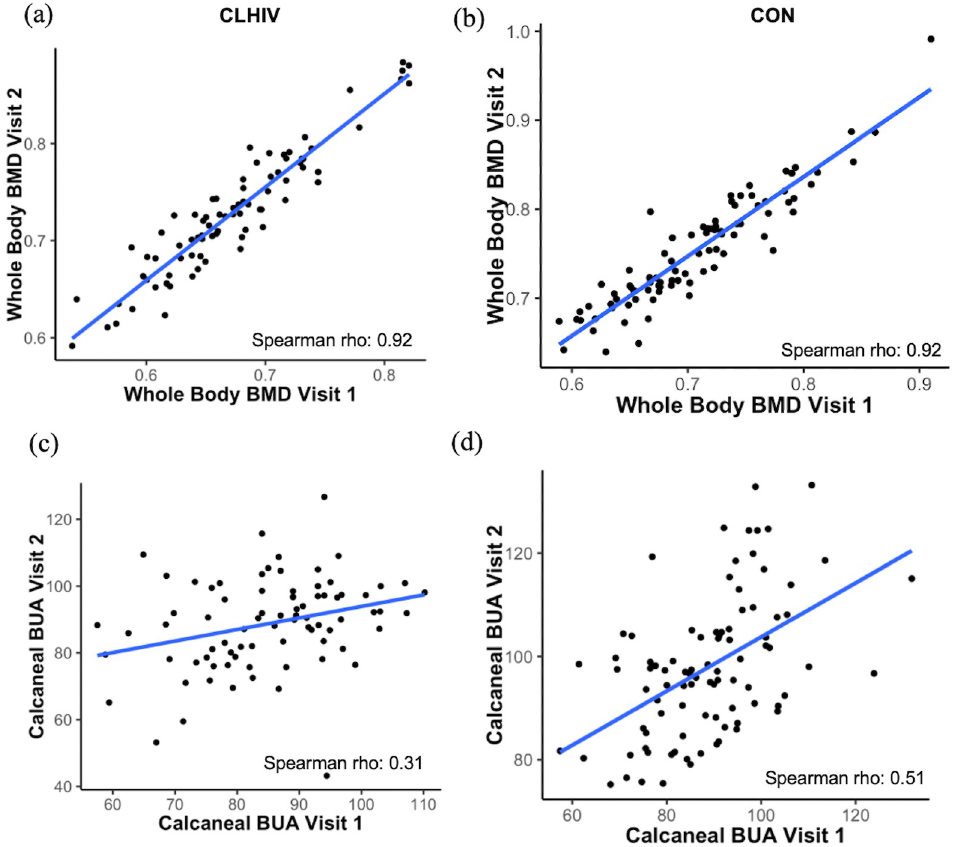
Fig 2. Within-subject Spearman correlations between baseline (Visit 1) and follow-up (Visit 2) visits, stratified by study group. (a) Correlation between baseline and follow-up whole body DXA BMD within CLHIV group. (b) Correlation between baseline and follow-up whole body DXA BMD within control group. (c) Correlation between baseline and follow-up calcaneal BUA. (d) Correlation between baseline and follow-up calcaneal BUA. Blue lines indicate the line of best fit from Spearman correlation. BMD: bone mineral density; BUA: broadband ultrasound attenuation; DXA: dual-energy x-ray absorptiometry.